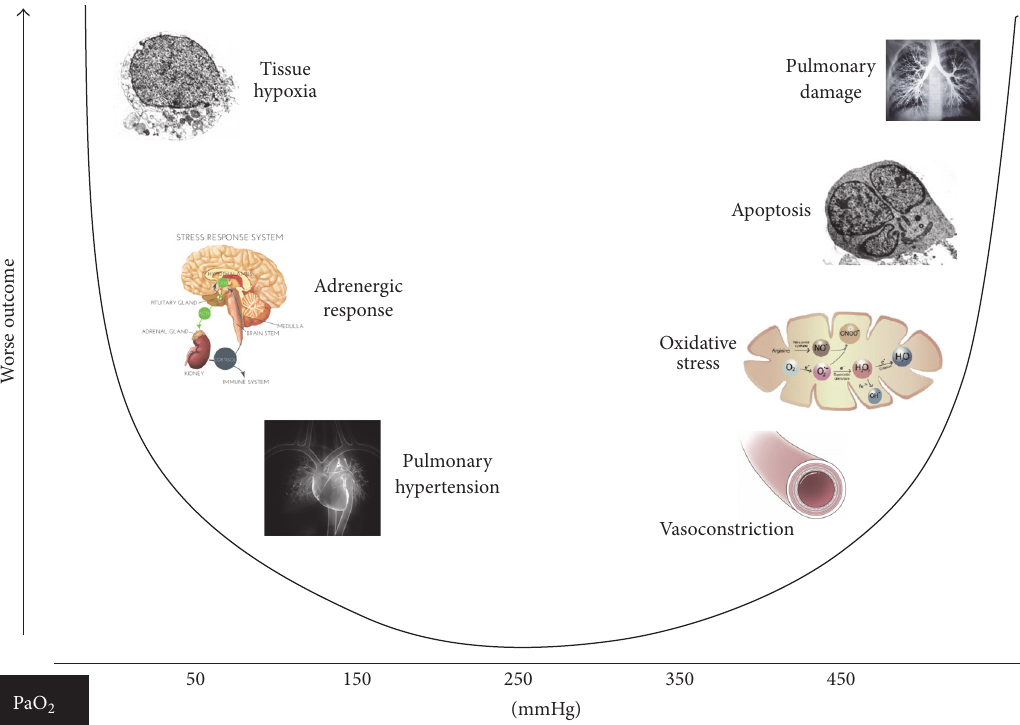
Figure 1: Schematic showing U-shaped association of PaO 2 with